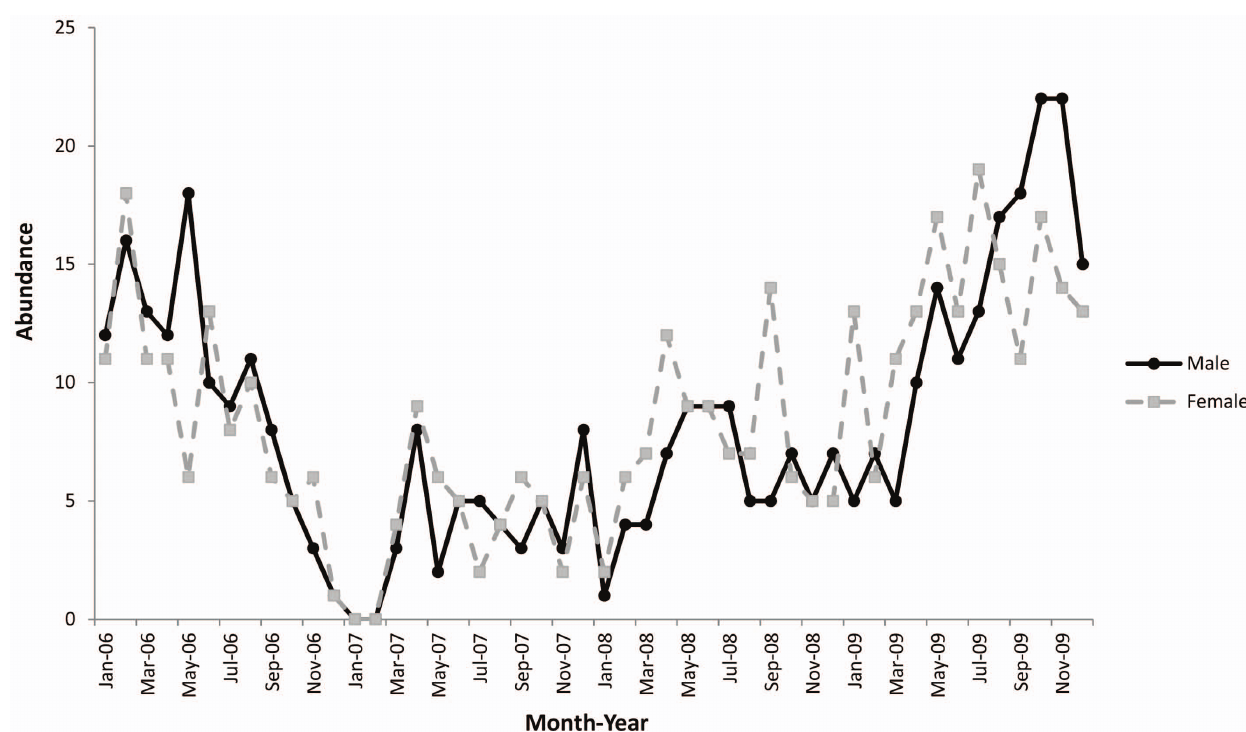
Figure 3. Monthly abundance of adult H.whitei recorded in 60 min dive surveys from 2006–2009 at the non-sanctuary site Seahorse Gardens, Port Stephens.